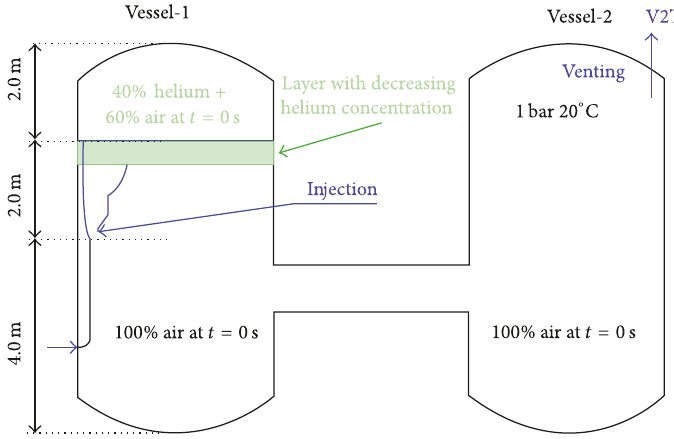
Figure 2: Initial and boundary conditions in PANDA ST1 7.